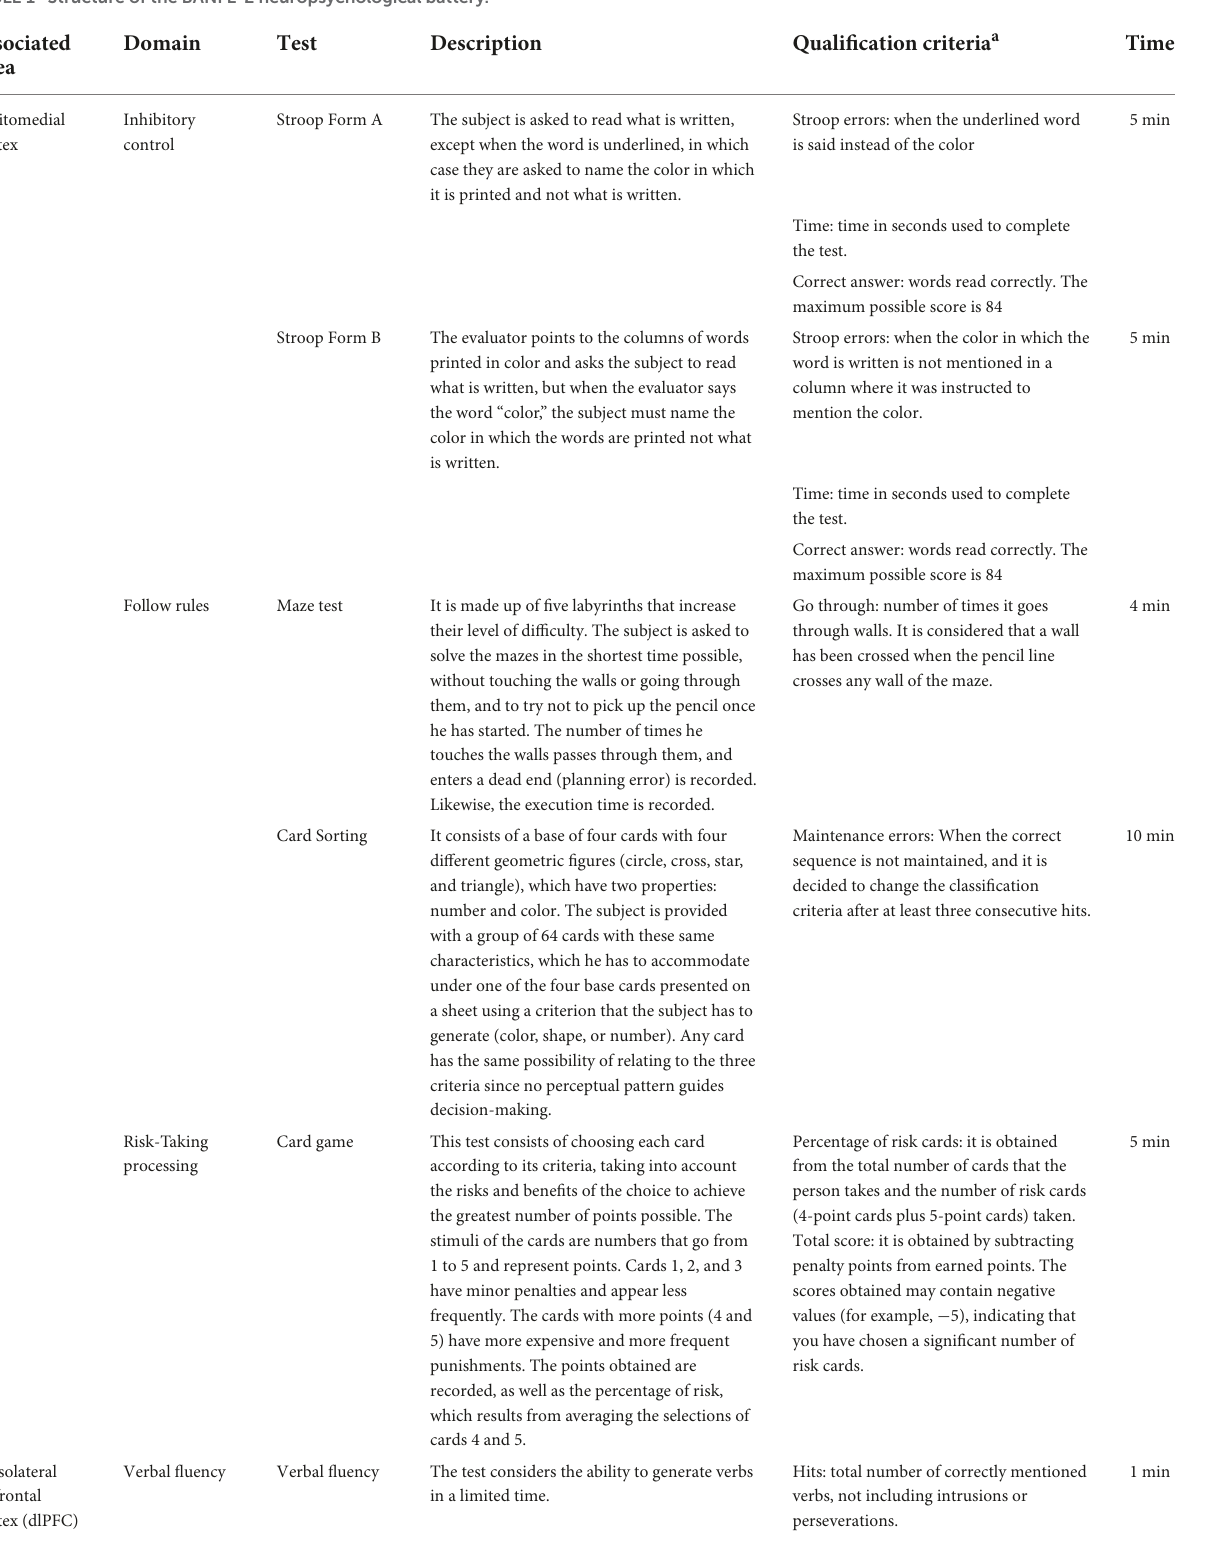
TABLE 1 Structure of the BANFE-2 neuropsychological